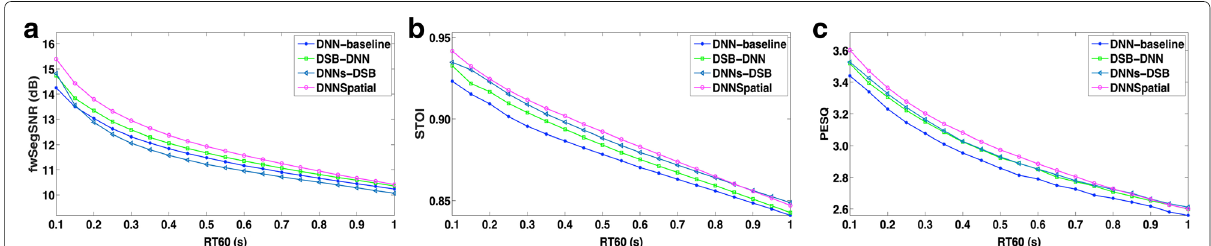
Fig. 7 Average 2-microphone fwSegSNR ( a ), STOI ( b ) and PESQ ( c ) of three DNN-based array dereverberation systems at different RT60s